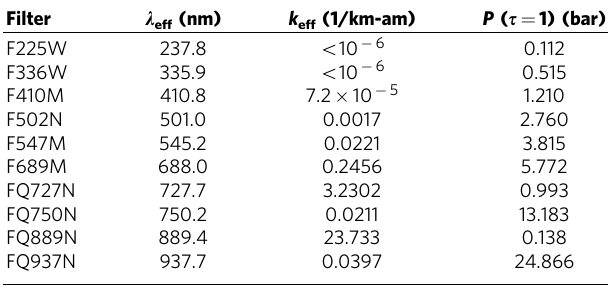
Table 1 | HST filter list and atmospheric altitude